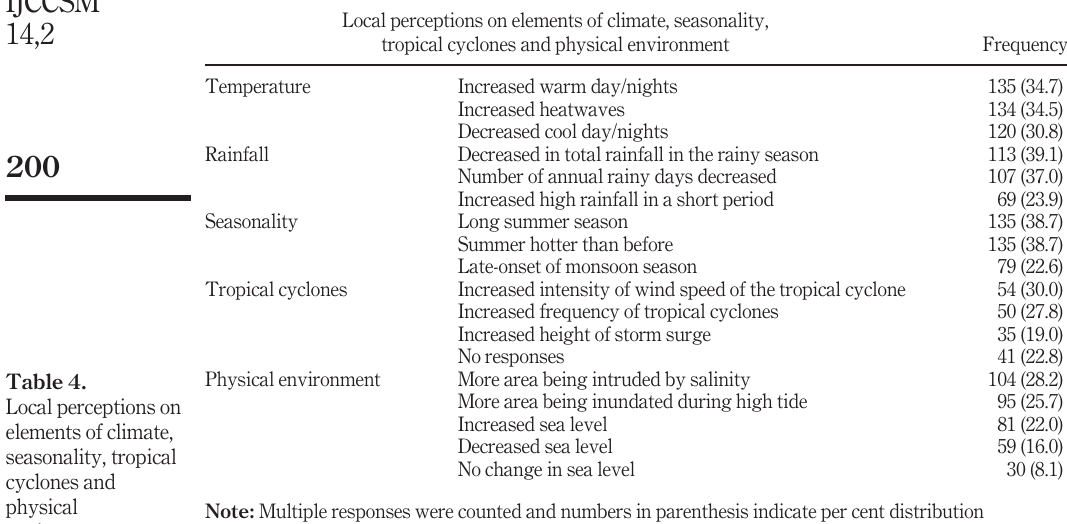
rainfall in a short period. To verify their claims, fi shers ’ perceptions of precipitation changes were compared with rainfall data from a local meteorological station. The seasonal rainfall (Monsoon season – June, July, August and September) time series for 18 years (1991 – 2008) does not show any statistically signi fi cant changes (at 5% signi fi cance level) over this period (Figure 2). The decadal frequency (an aggregate of 10 years) of major cyclonic storms striking over coastal regions of Bangladesh during 1970 – 2017 (Figure 3) shows that there is a decreasing trend in the frequency of total major cyclonic storms land fi lling over Bangladeshi coasts during the three decades, except for the 1980s – 1990s and the rate of decadal decrease was 55.6% during the 1970s to 1980. Between the 1980s and 1990s, the trend reversed towards increased cyclones at the rate of 50%. There has been a 50% decrease in the frequency of total signi fi cant cyclones in the fi rst decade of the 21st century from the previous decade.